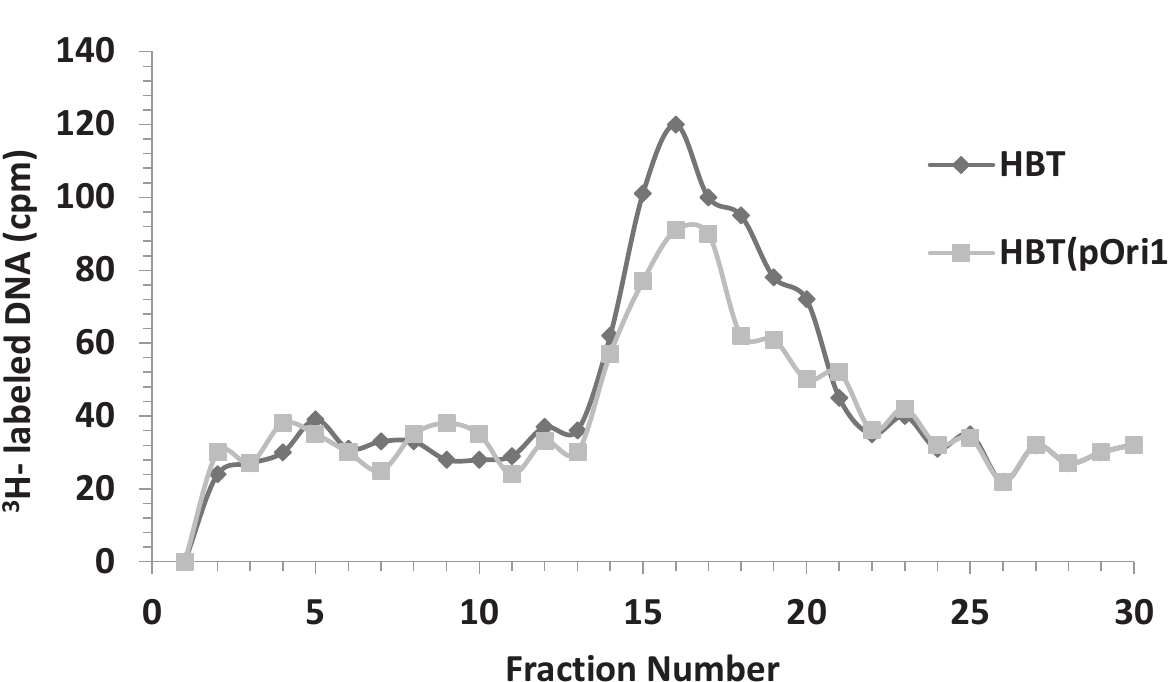
Figure 7. DNA fractionation after a second CsCl equilibrium density centrifugation of intracellular 3 H-labeled λ DNA isolated from infec ted HBT or HBT(pOri1). CsCl fractions containing viral DNA, and separated from bacterial DNA through a first CsCl gradient, were pooled and run through a second CsCl in order to isolate newly synthesized DNA. At the end of the run, DNA was fractionated and the radioactivity in each fraction, from the lowest density fraction (fraction #1) to the highest density (fraction #30) was determined by scintillation counting. Under the conditions of centrifugation the density of LL DNA is around fractions 15 – 16. Note that the DNA shoulder past fraction 16 is more prominent in HBT compared to